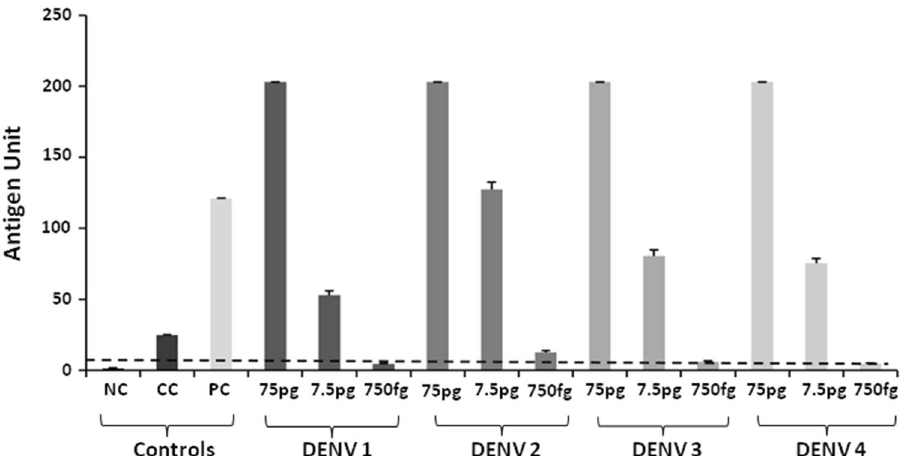
Figure 3. Detection of NS1 antigen of dengue serotypes. Recombinant Dengue NS1 antigens from all serotypes of dengue (DENV1 to DENV4) were tested at different concentration following manufacturers’ instructions. Cut-off value is indicated by a horizontal line. NC Negative control, CC Calibrator control, PC Positive control, DENV Dengue